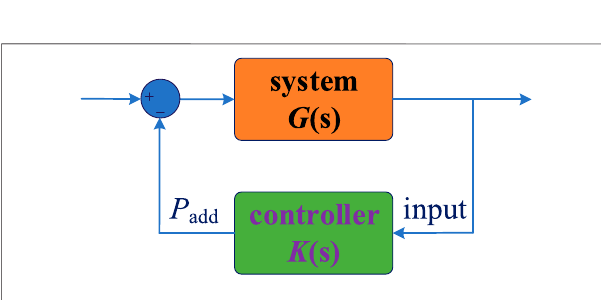
FIGURE 5 | Relationship between the supplementary control and